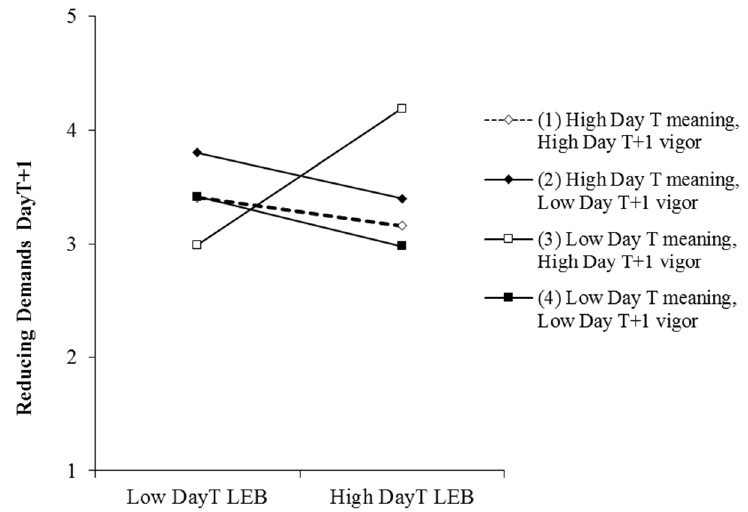
Figure 3. Moderating effect of employee day T work meaning and day T+1 vigor on the relationship between day T leader empowering behaviors (LEB) and employee day T+1 seeking challenge.